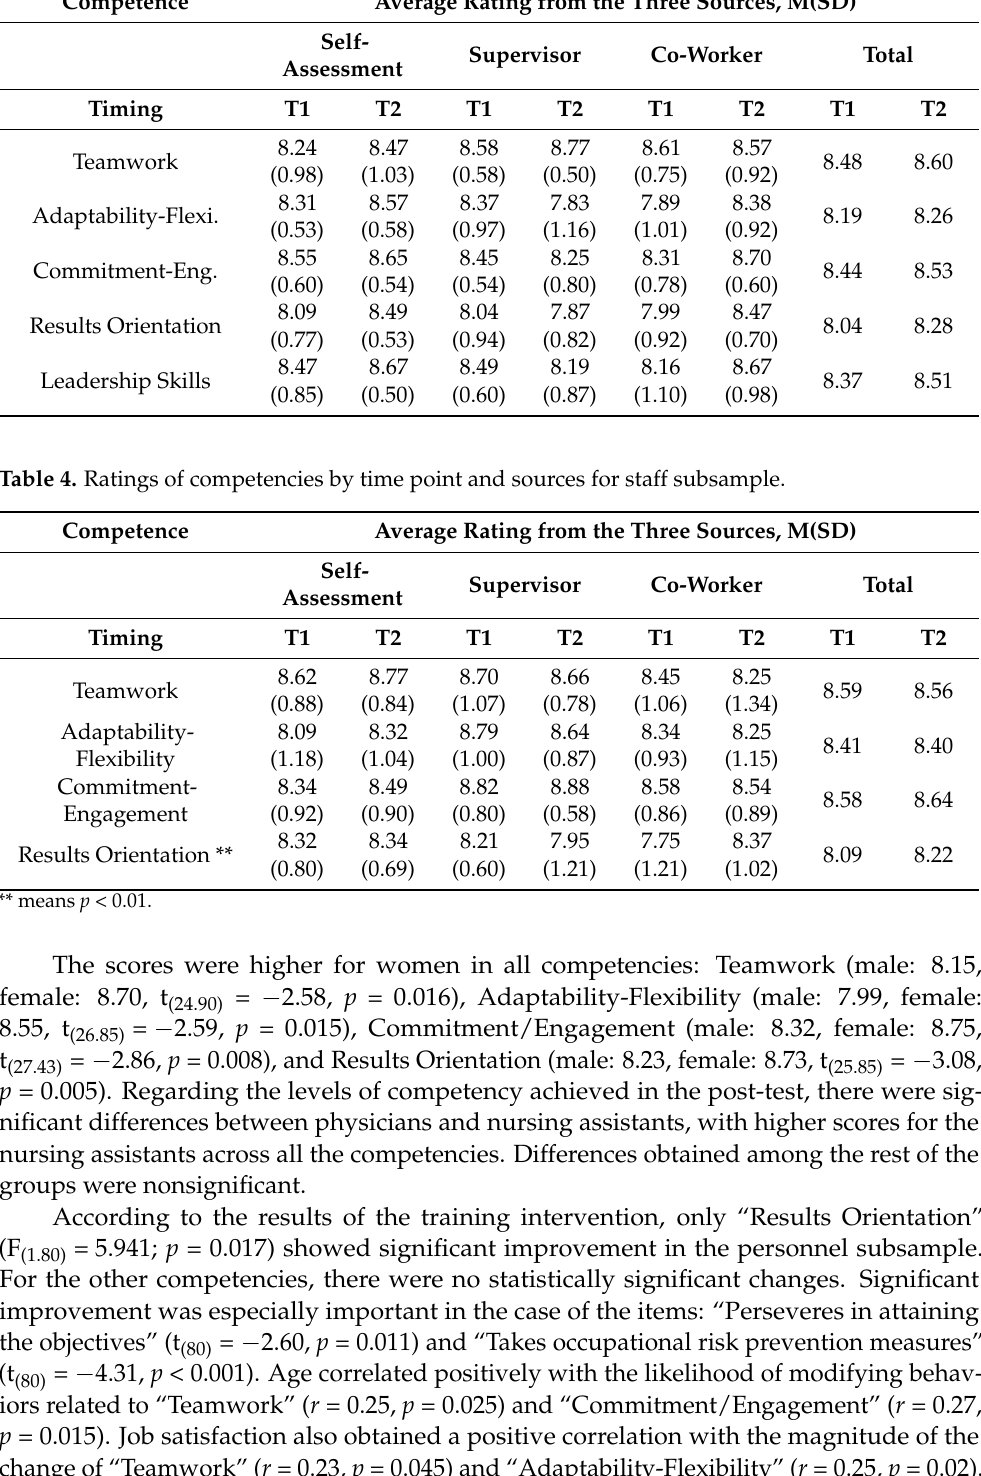
Table 3. Ratings of competencies by time point and sources for supervision subsample. Competence Average Rating from the Three Sources, M(SD) Self- Assessment